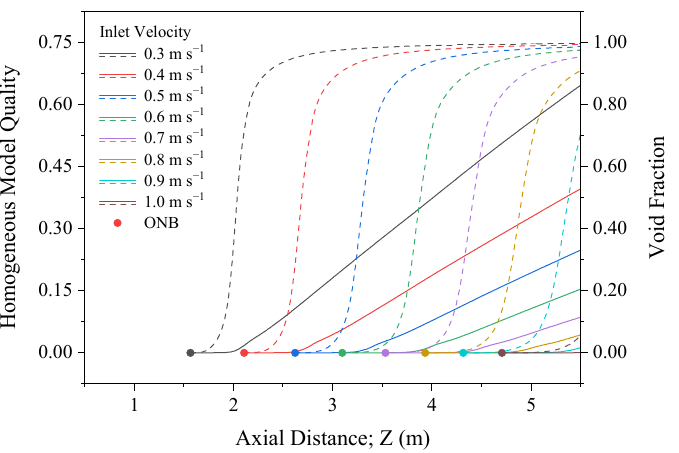
Figure 9. Homogeneous model quality distribution along the axial direction at inlet velocities from 0.3 m·s − 1 to 1.0 m·s − 1 (Dashed lines are void fraction).